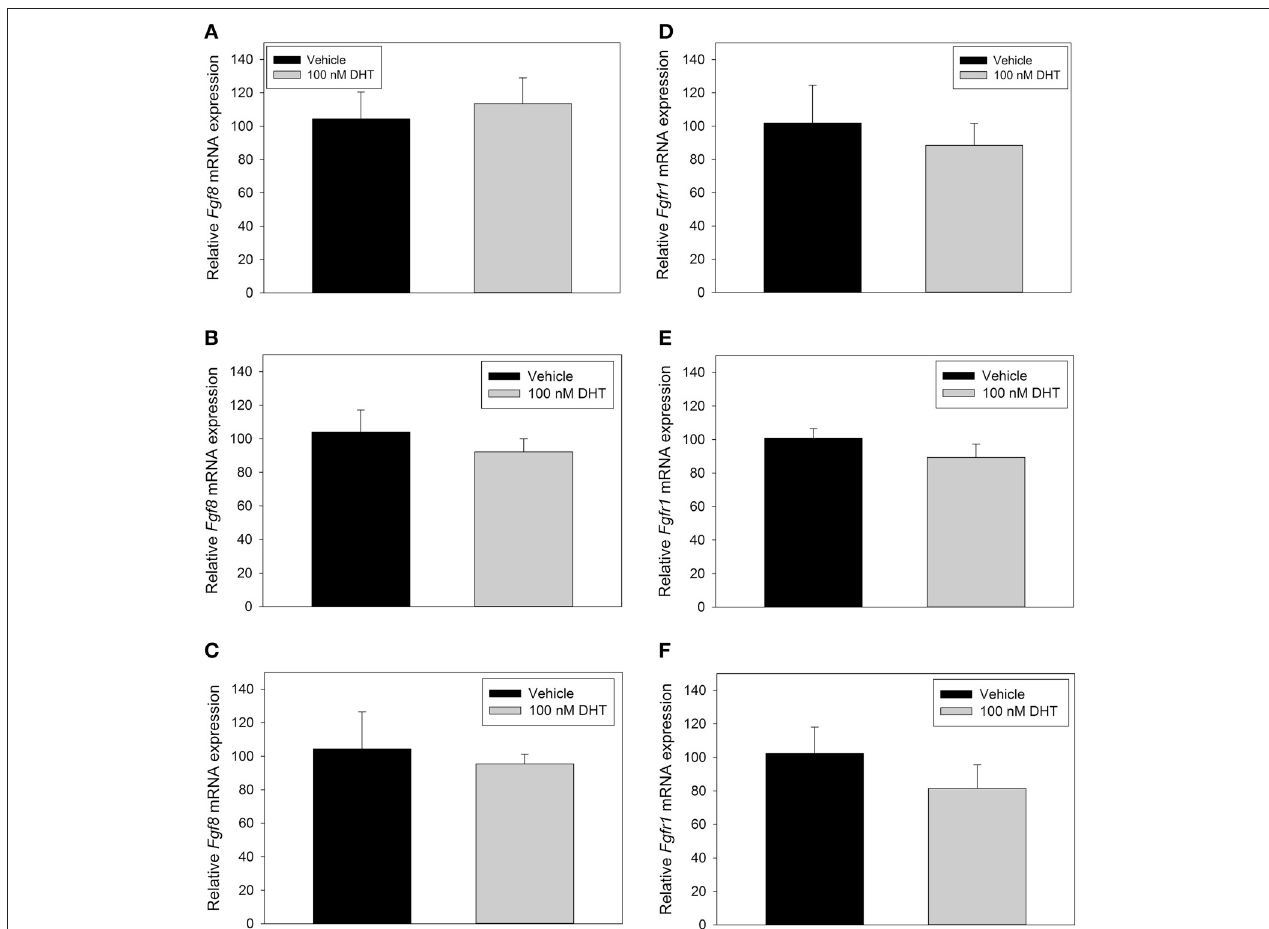
FIGURE 3 | RT-qPCR for Fgf8 (A–C) and Fgfr1 (D–F) mRNA in GT1-7 neurons treated for 2h with vehicle ( n = 4 ) or 100nM DHT ( n = 4 ), 4h with vehicle ( n = 6 ), or 100nM DHT ( n = 6 ), or 48h with vehicle ( n = 3 ) or 100nM DHT ( n = 3 ). DHT treatment did not signifigantly alter Fgf8 or Fgfr1 mRNA expression in GT1-7